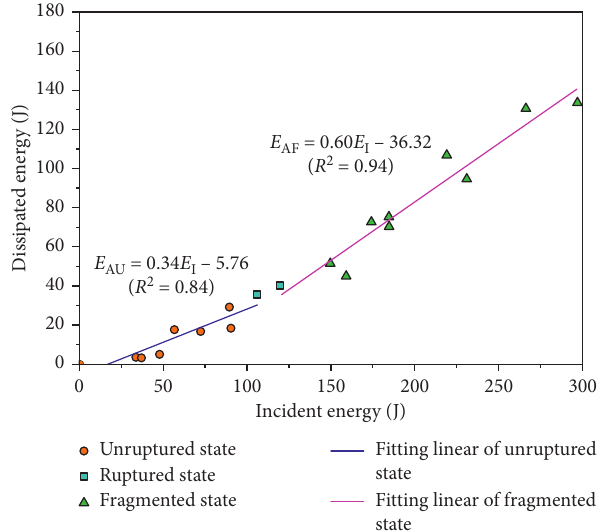
Figure 9: Incident energy versus dissipated energy of specimens under the three rupture states.